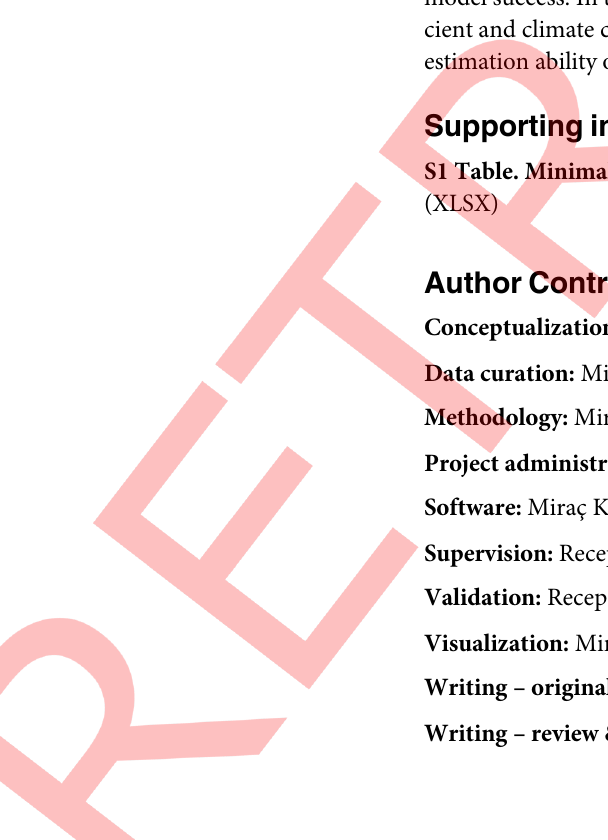
S1 Table. Minimal dataset of the study used to analyze, report, and interpret the